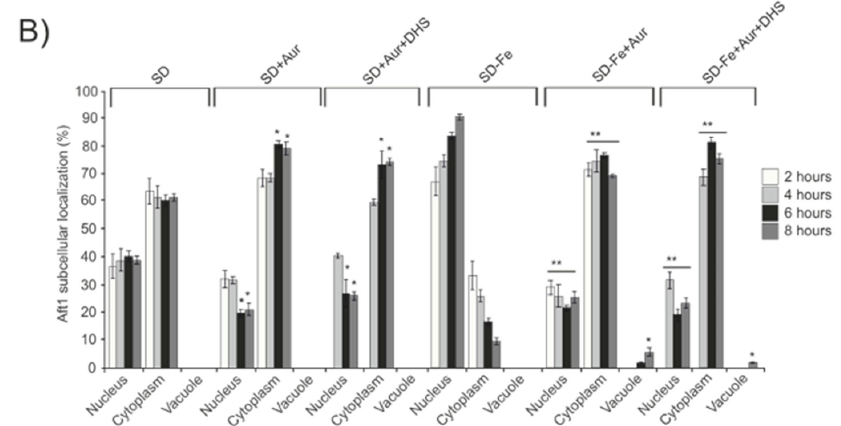
Figure 6. Complex sphingolipids signal Aft1 to localize to the nucleus upon iron depletion. wt cells expressing pAft1GFP were grown to OD 600 :0.4 in SD medium at 30 °C. ( A ) Aliquots were taken, washed and transferred to either SD, SD+Myr, SD-Fe or SD-Fe+Myr media. After 2 hours, the cultures with Myriocin (Myr) were divided in two halves and DHS was only added to one of them, the other half was maintained as a control. Samples were collected for in vivo observation in the fluorescence microscope, every two hours for eight hours. ( B ) Aliquots were taken, washed and transferred to SD, SD+Aur, SD-Fe or SD-Fe+Aur media. After 2 hours the cultures with Aureobasidin A (Aur) were divided into two halves and DHS was only added to one of them. Samples were collected for in vivo observation in the fluorescence microscope at the indicated times. * 0.05 > p > 0.01; ** 0.01 > p > 0.001.